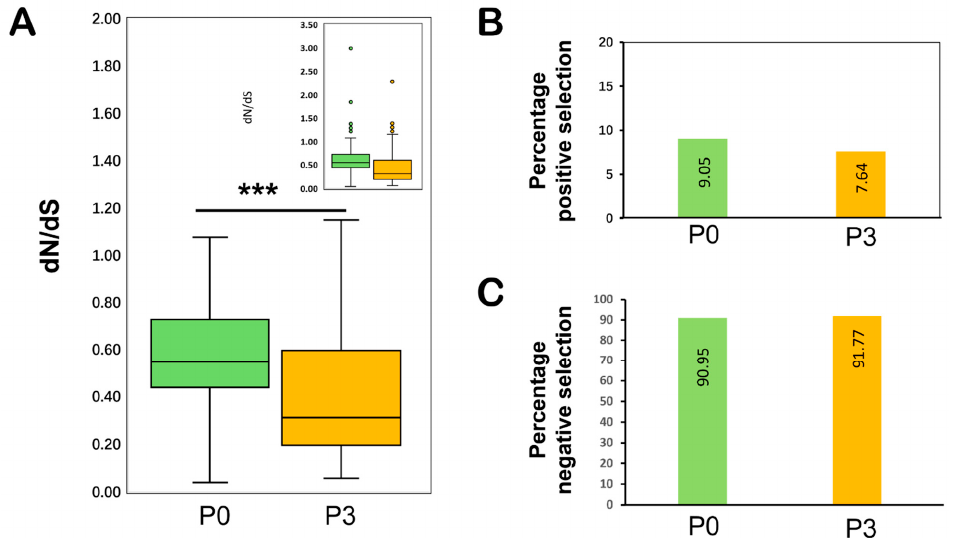
Figure 5. ( A ) Selection pressure was estimated by the calculation of non-synonymous to synonymous substitution ratios (dN/dS). Box plots correspond to dN/dS ratio for the TuYV-encoded P0 gene and P3 gene. The median values are represented by the horizontal lines inside the box, while inset shows the data with outliers indicated by small circles. Asterisks denote significance: *** p < 0.001. ( B ) Percentage of sites evolving under positive selection pressure in TuYV-encoded P0 gene and P3 gene. ( C ) Percentage of negatively selected sites among TuYV-encoded P0 gene and P3